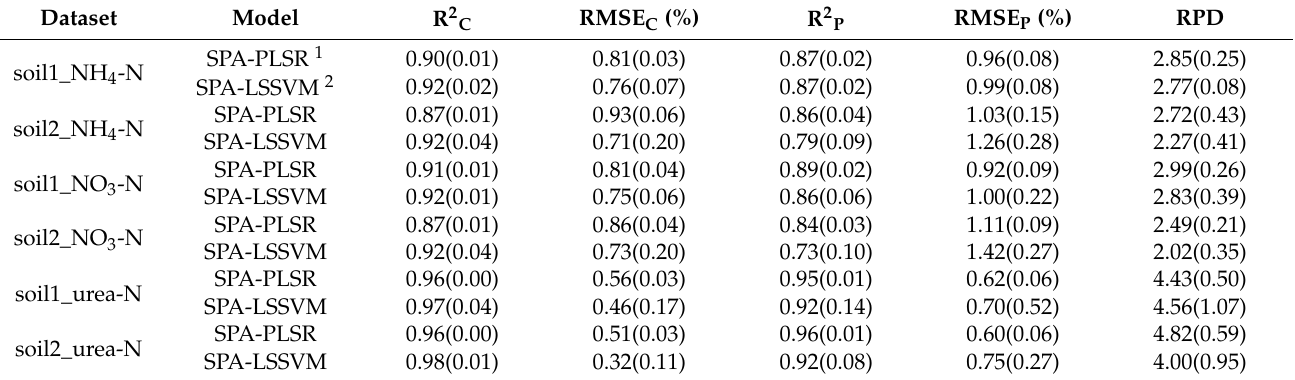
Table 5. PLSR and LSSVM model performances based on characteristic wavelengths selected by